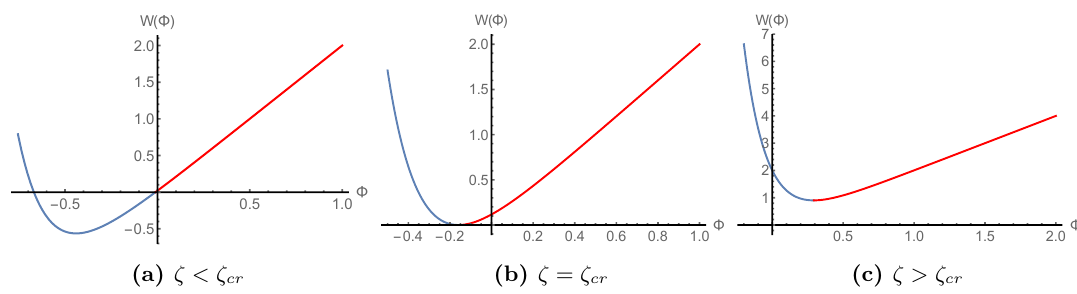
Figure 15. W (Φ) for different values of ζ . Red part corresponds to the spectrum of thermodynamical stable black